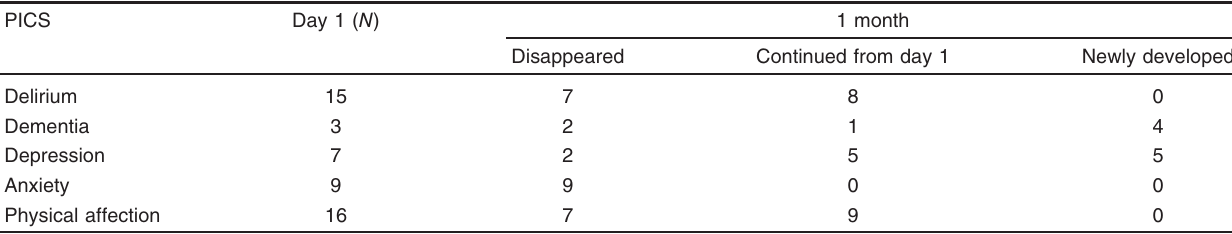
PICS, postintensive care Table 3 Comparison between patients with and without postintensive care syndrome Groups